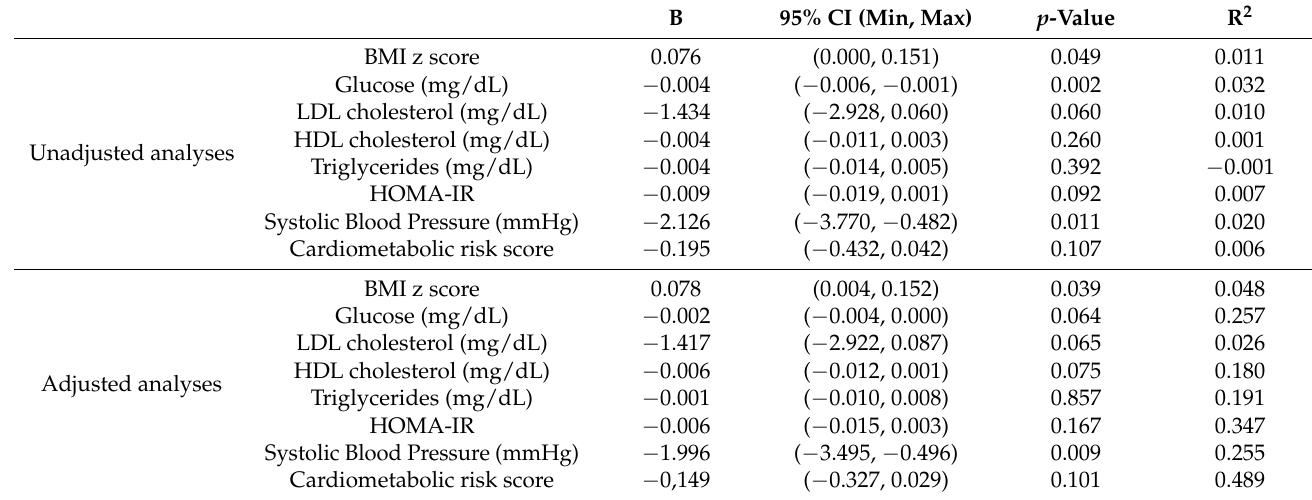
Table A3. Linear regression analyses on the association between dietary fibre intakes at age 8 years on cardiovascular health